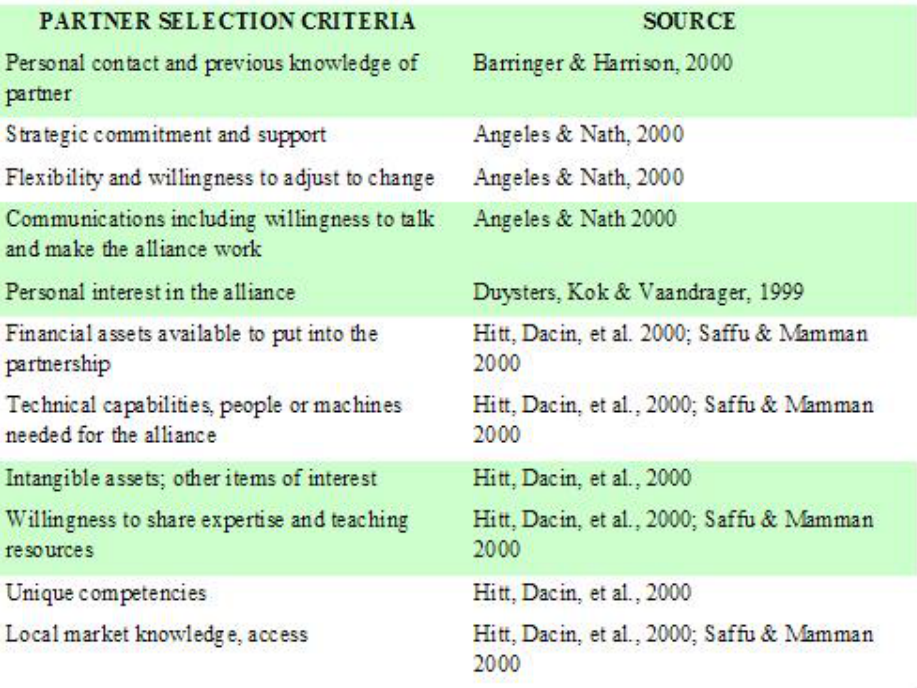
Table 1. Partner Selection